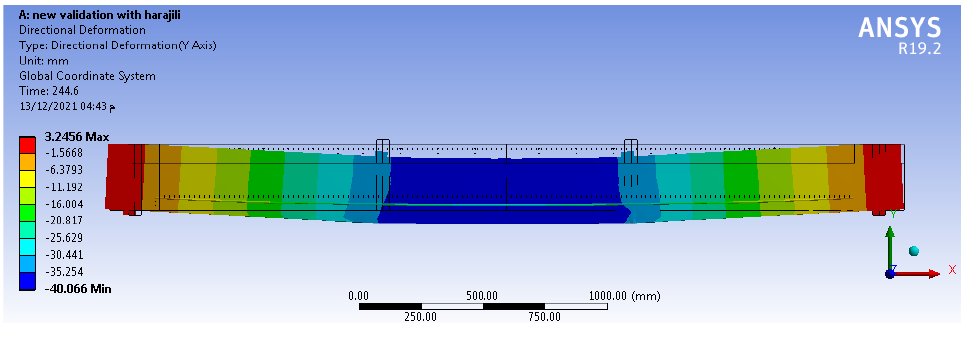
Figure 11. Vertical deflection at failure of specimen T2S.